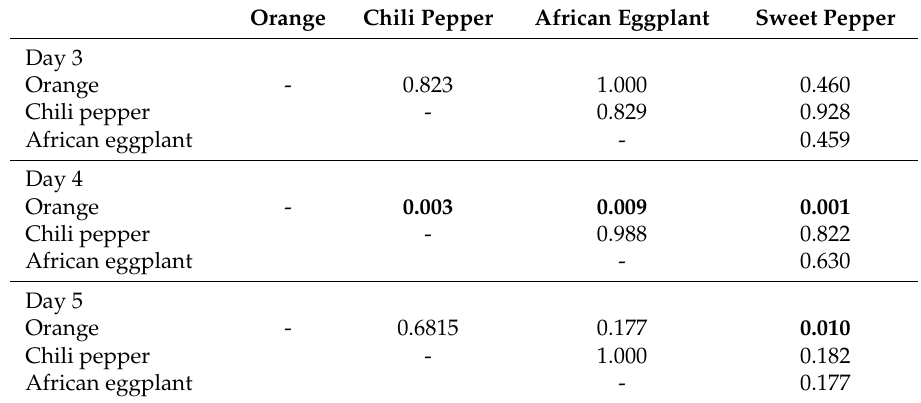
Table 5. Pairwise comparison on mean number of eggs laid by Thaumatotibia leucotreta reared from orange and solanaceous fruit on three peak days of egg laying. Orange Chili Pepper African Eggplant